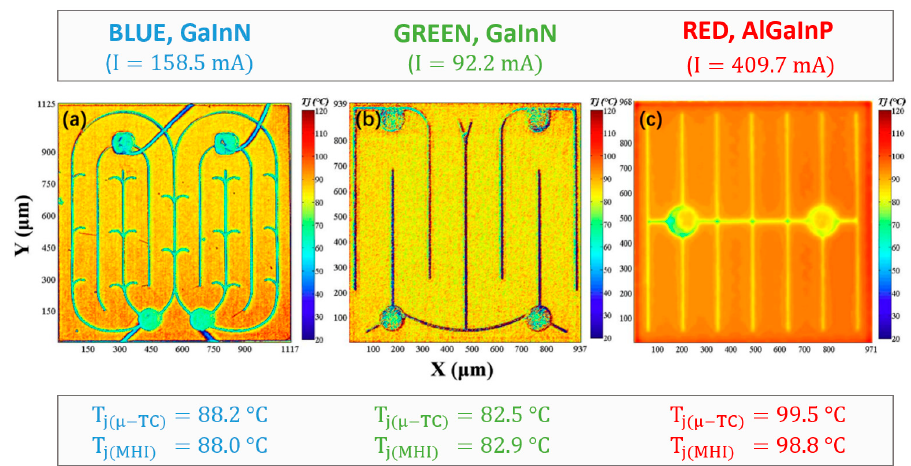
Figure 3. Two-dimensional (2D) temperature distribution of a ( a ) blue, ( b ) green, and ( c ) red LED was measured with microscopic hyperspectral imaging (MHI) under a heat sink temperature of 75 °C. To prevent temperature fluctuations, an average of 2 × 2 pixel temperature was taken in both X and Y directions. Color, material system, and driving current of each LED are given at the top, while T j obtained by microthermocouple and MHI measurements are given at the bottom. The average standard deviation between T j( μ -TC) and T j(MIH) was found to be 0.9 °C. Reprinted with permission from Ref. [89]. Copyright 2004, IEEE”.